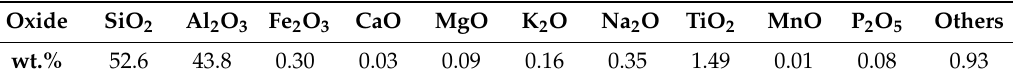
Figure 2. X-ray diffraction pattern of the metakaolin used in this study. It contains crystalline phases such as illite (an aluminosilicate), anatase and quartz (crystalline silica). Table 2. Content of the major elements in the metakaolin used in this study, as determined by X-ray diffraction (XRD).